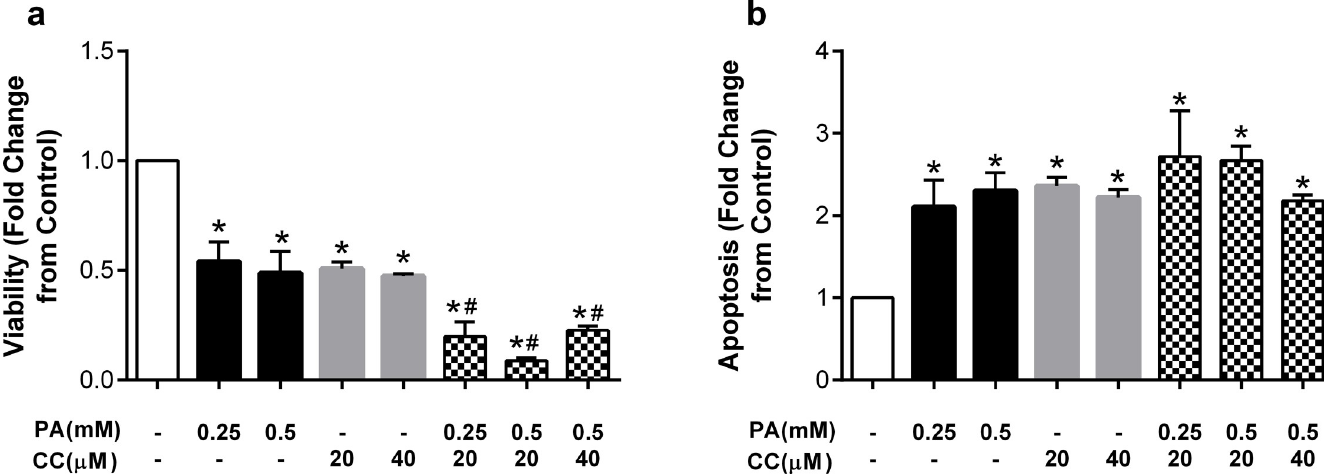
Fig 8. The AMPK inhibitor CC exacerbates palmitate-induced decreases in viability. Cells were pretreated with compound C (CC; 20 or 40 μ M) and then co- incubated with palmitate (PA). Fold change from control in a) viability and b) apoptosis after treatment with palmitate (PA), compound C (CC), or a combination of both. Data are expressed as mean ± SEM; n = 3–5 independent experiments; � p < 0.05 vs control, #p < 0.05 vs both PA concentrations.